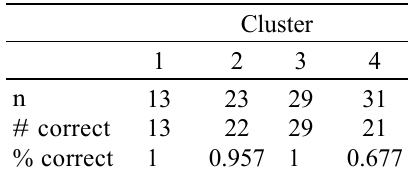
Table 4. Descriptives of the correct answers for each of the cluster.